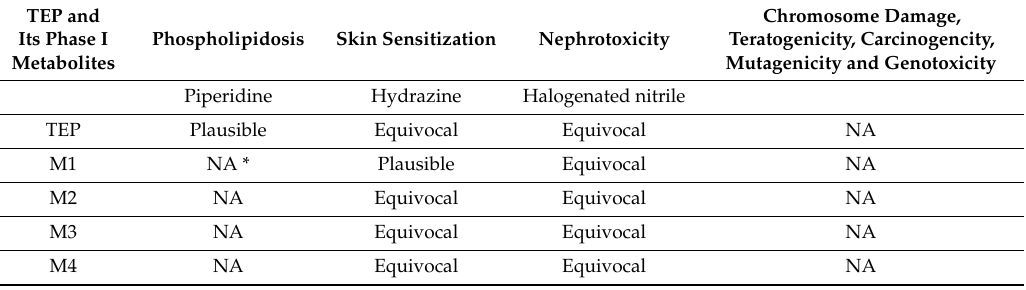
Table 1. Qualitative toxicity prediction of the TEP and its phase I metabolites by DEREK module of StarDrop software.